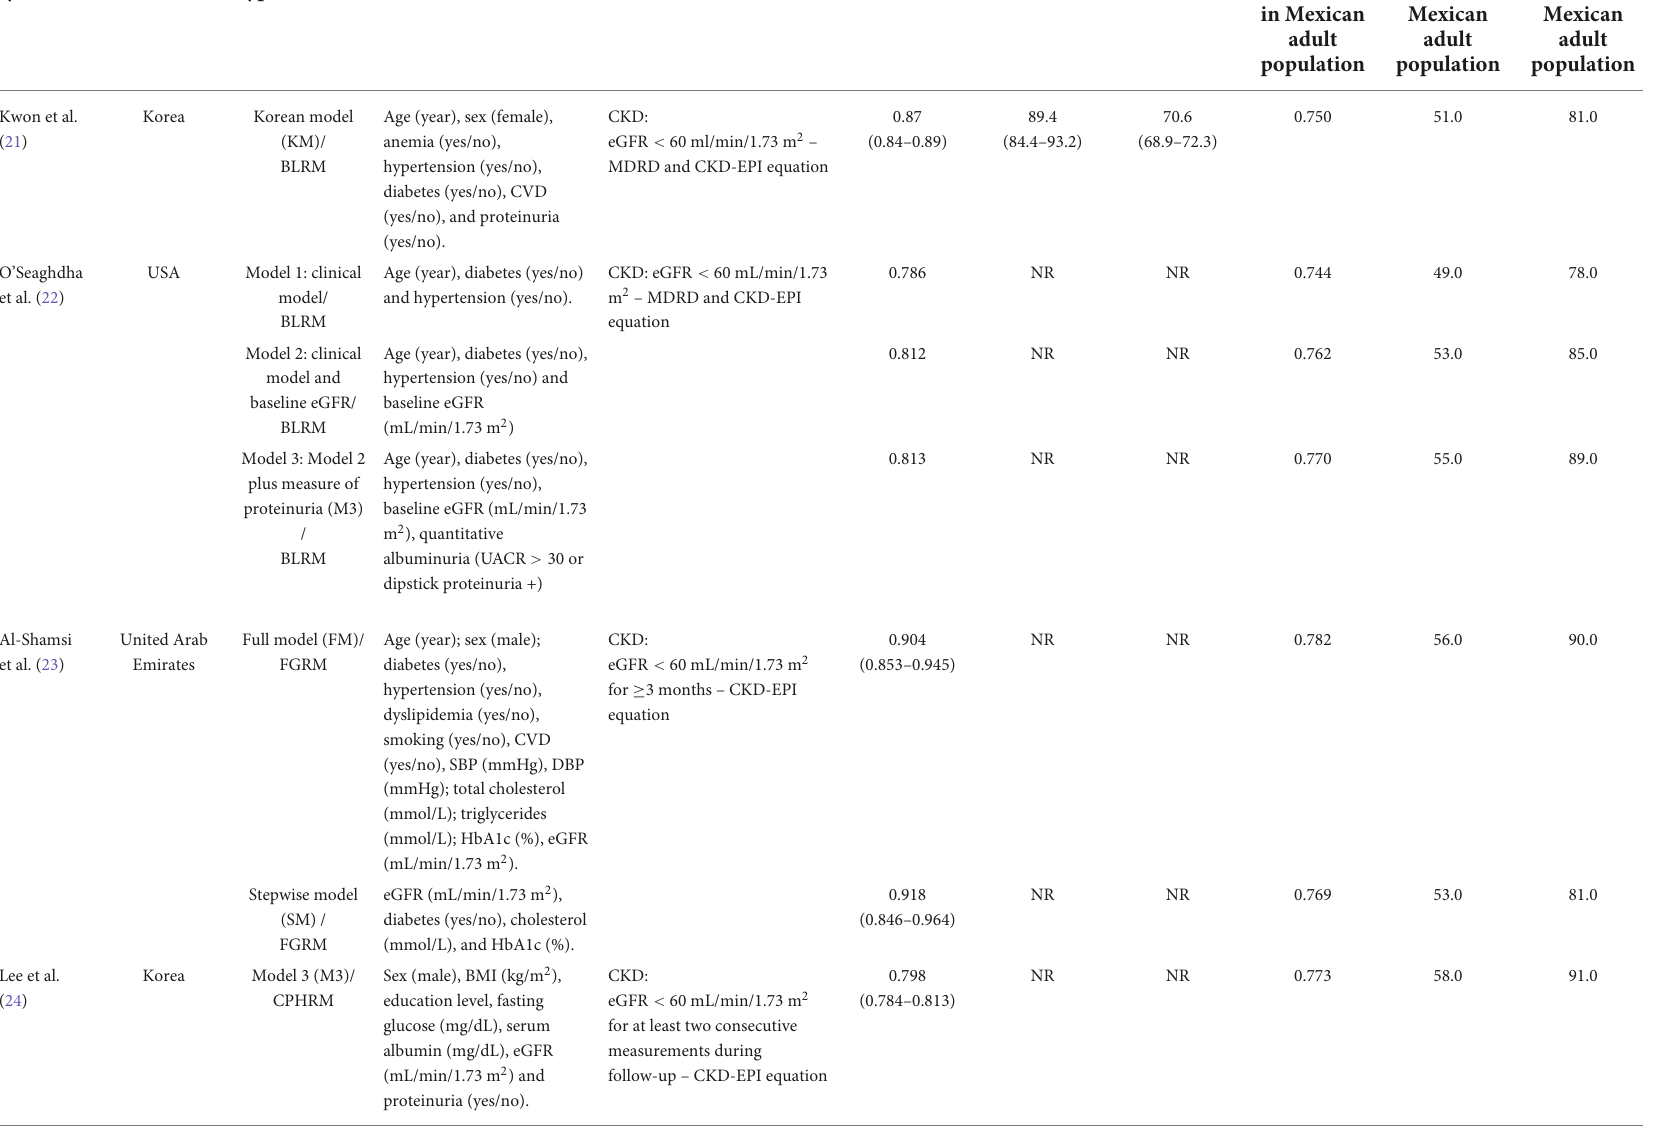
TABLE 3 External models validation in Mexican adult